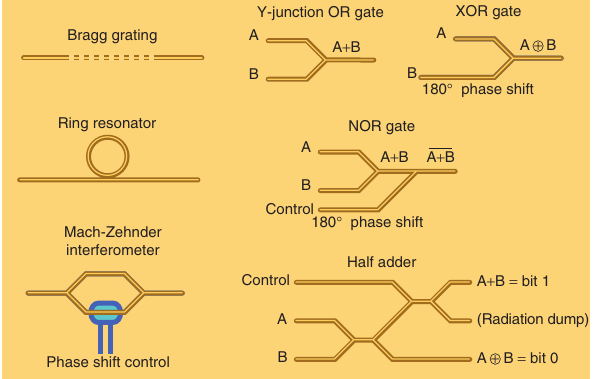
Figure 4: Plasmonic waveguide devices for performing optical processing. The logic circuits operate using phase shifts and